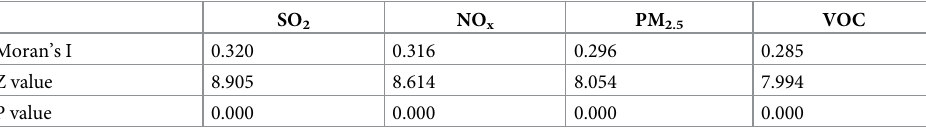
Table 7. Global Moran’s I statistic for pollutant emissions from industrial enterprises.